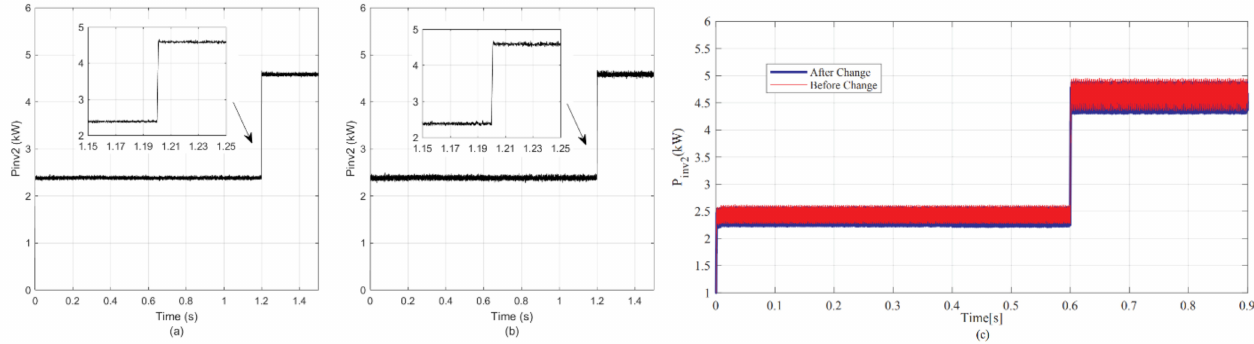
Figure 16. Active power of ACDG1 inverter (inv2) under two different sets of MG parameters, ( a ) under first set, ( b ) under the second set, ( c ) under two different sets of MG parameters in reference